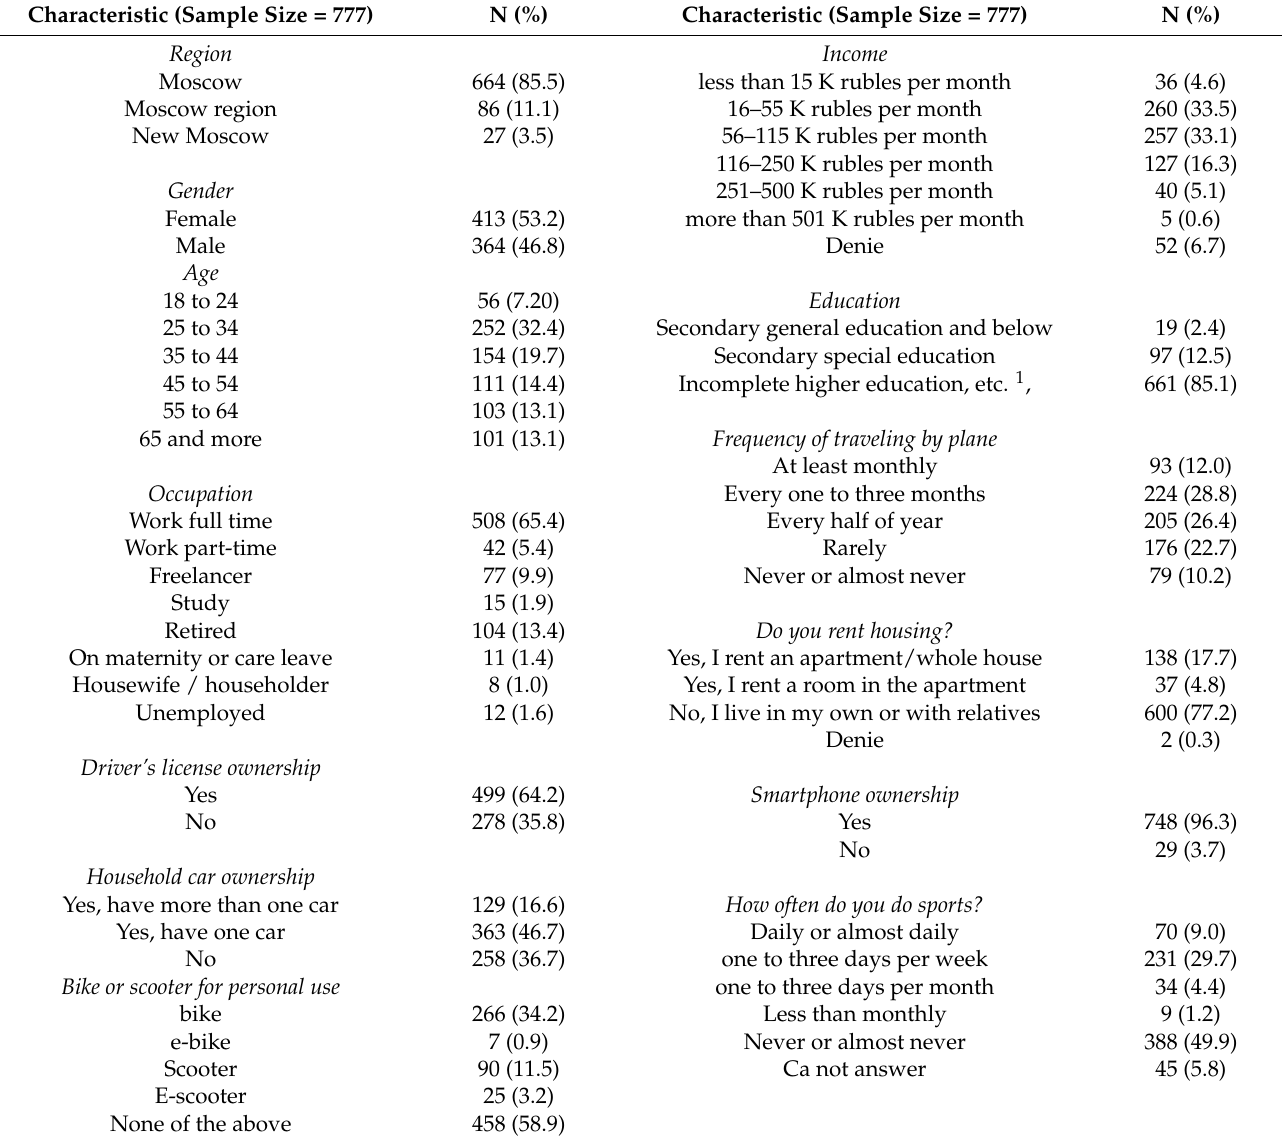
Table 4. Selected socio-demographic characteristics of the